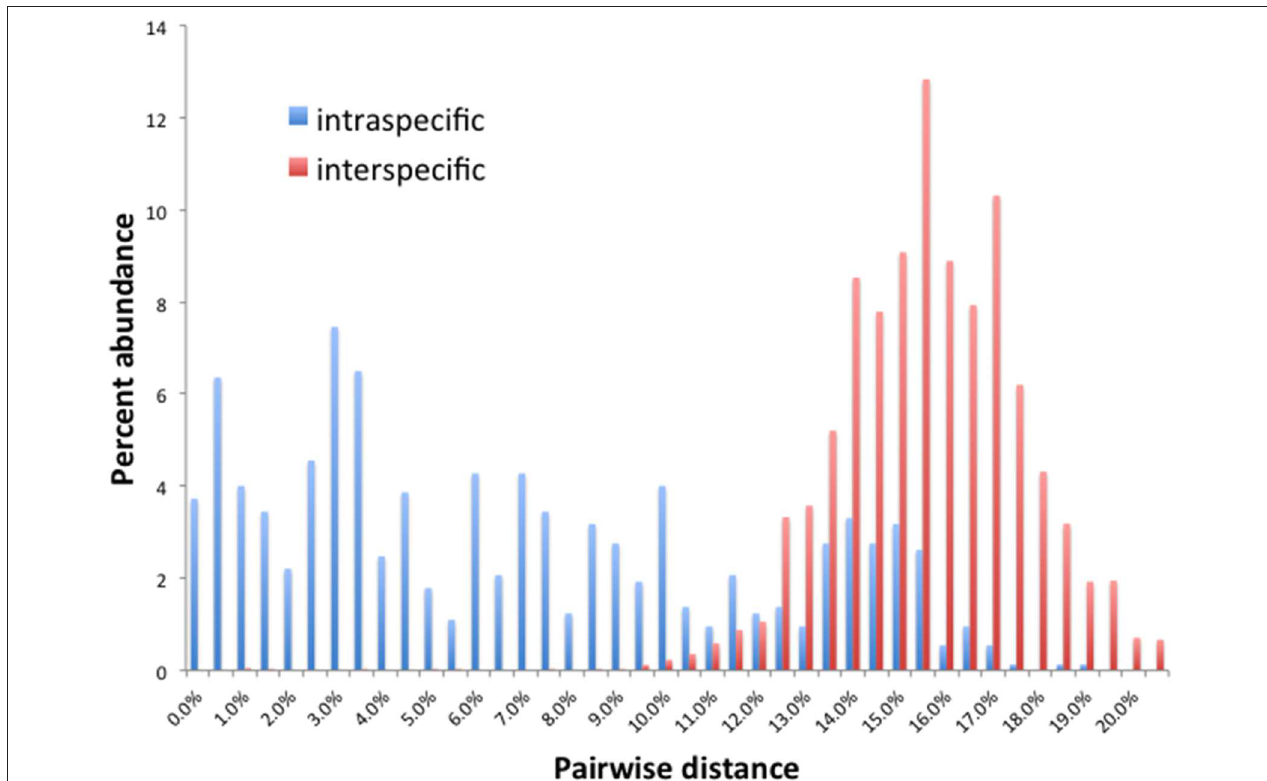
FIGURE 2 | Frequency of uncorrected “ p ” intra- and interspecific COI